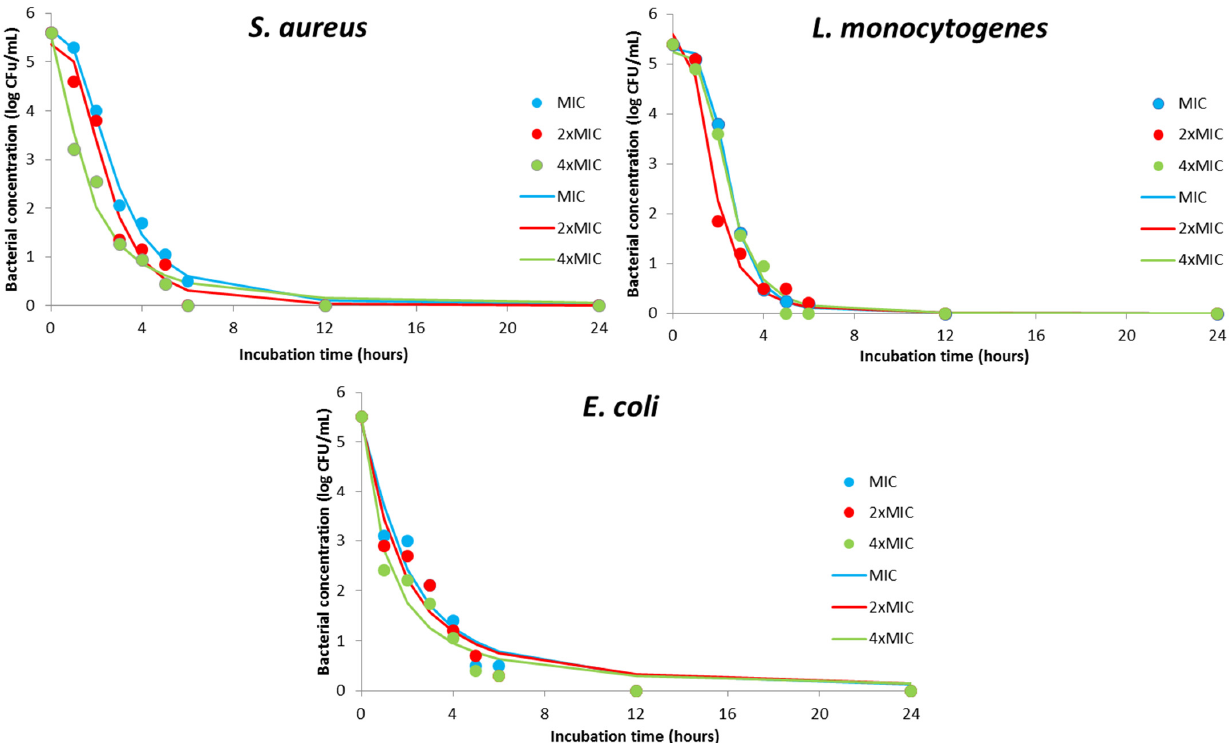
Figure 3. Kinetics modeling for pharmacodynamics potential of antimicrobial activity using MIC, 2×MIC, and 4×MIC of DMH (markers signify the experimental data; lines indicate predictive results).